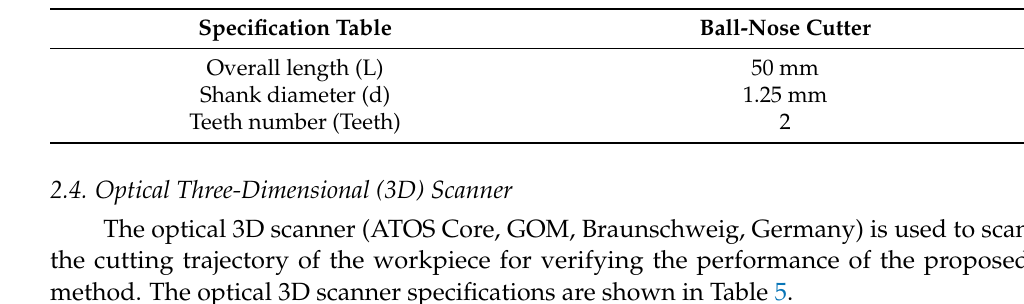
Table 4. Specifications of milling cutter.